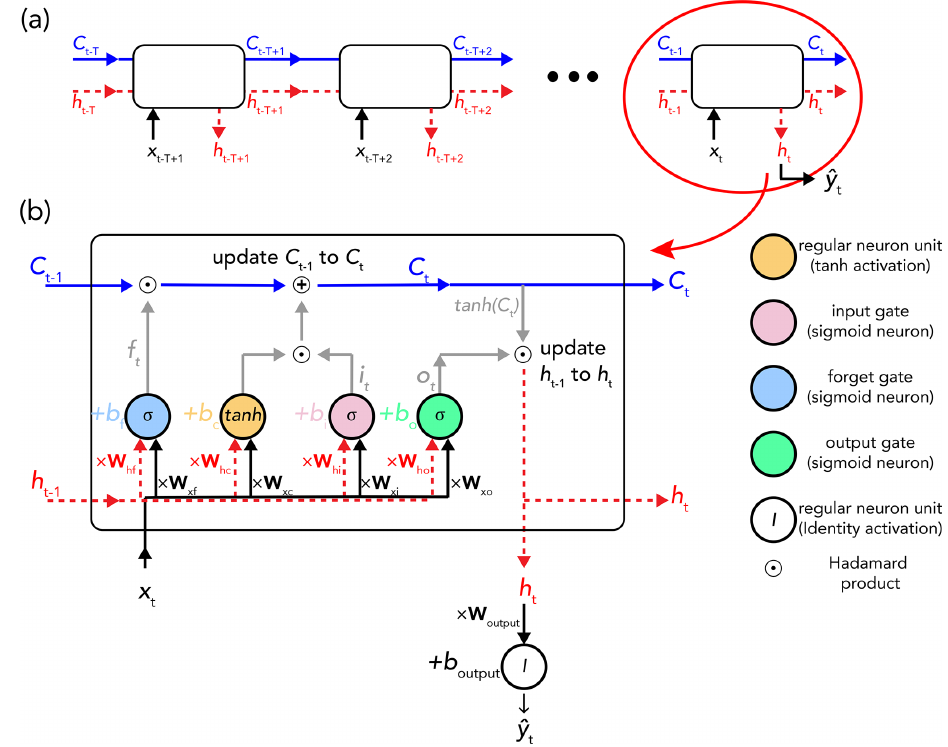
Figure 7. (a) Time-unfolded schematic representation of data processing for a single sample consisting of T time steps – from time step t − T + 1 to time step t . (b) Data processing of the last time step of the above sample through an LSTM cell. x t is the input of time step t , h t is the hidden state (dashed red line), C t represents the cell state (solid blue line), and σ and tanh are the respective sigmoid and hyperbolic tangent functions. The figure is adapted from Olah (2015). Table 1. Notation, dimensions, and definition of the terms and operators in Eqs. (4) to (9) for the forward pass of a standard LSTM cell involving the forget, input, and output